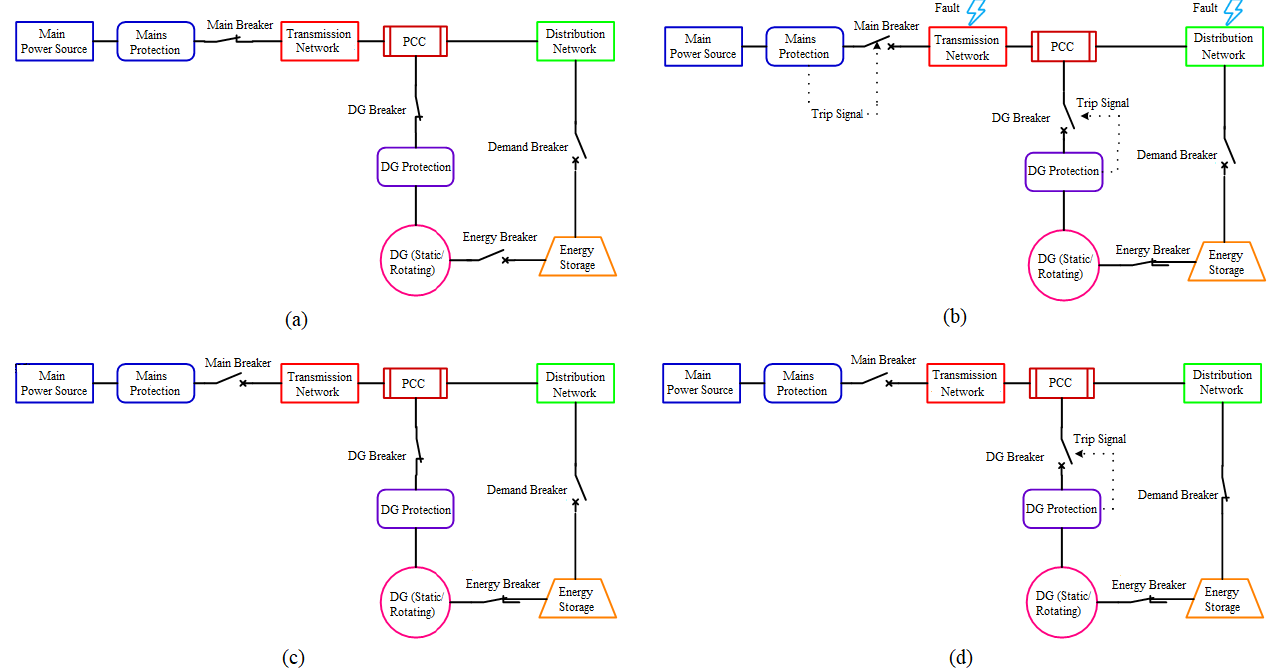
Figure 10. Energy management strategies for different operating conditions: ( a ) normal state, ( b ) fault condition, ( c ) balanced islanding condition, and ( d ) imbalanced islanding condition.